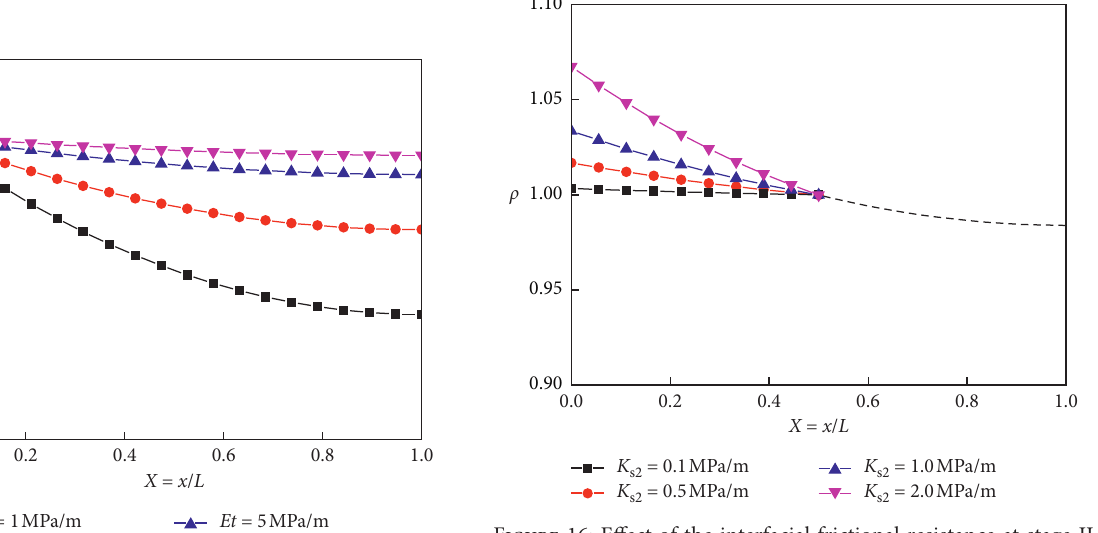
Figure 16: Effect of the interfacial frictional resistance at stage II on K s 2